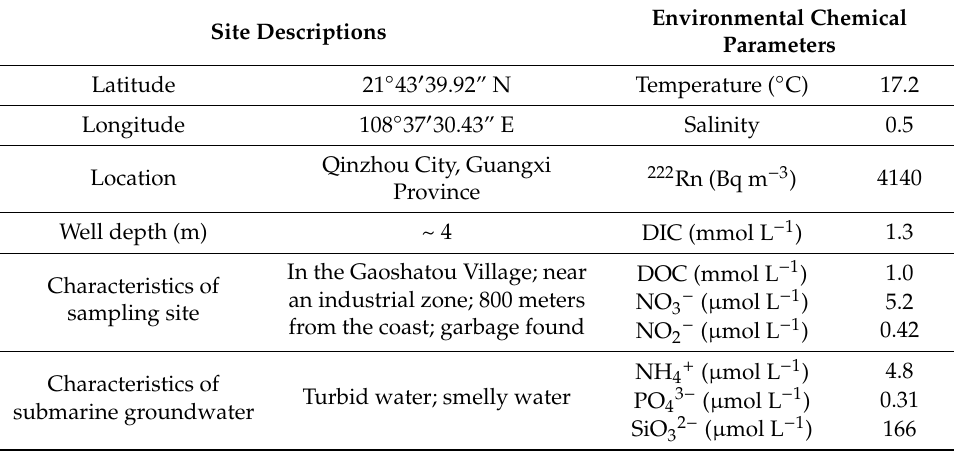
Descriptions of the sampling site and environmental chemical parameters of submarine